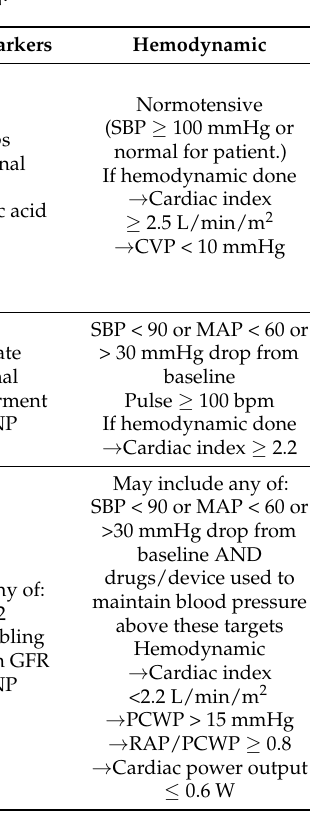
Table 1. The Society for Cardiovascular Angiography and Interventions (SCAI) classification of cardiogenic shock into five stages of increasing severity (A–E)